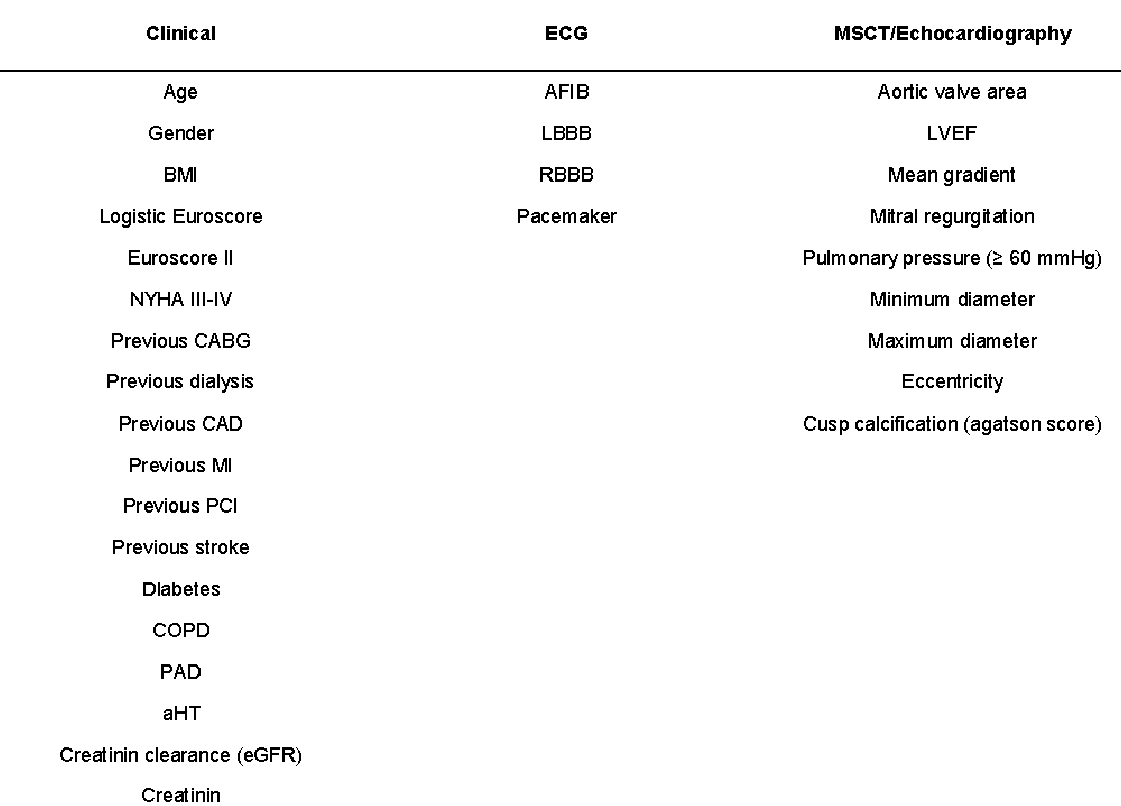
Figure 1. Variables used for the propensity matching.